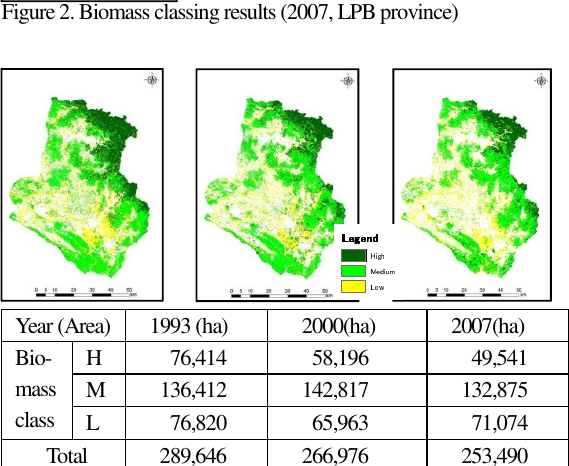
Figure 3. Biomass classing results (1993,2000, and 2007, Khamkeut district( BLK)) based on 491 visual interpretation data Overall accuracy of matching of biomass classification was approximately 60% in both LPB province and Khamkeut